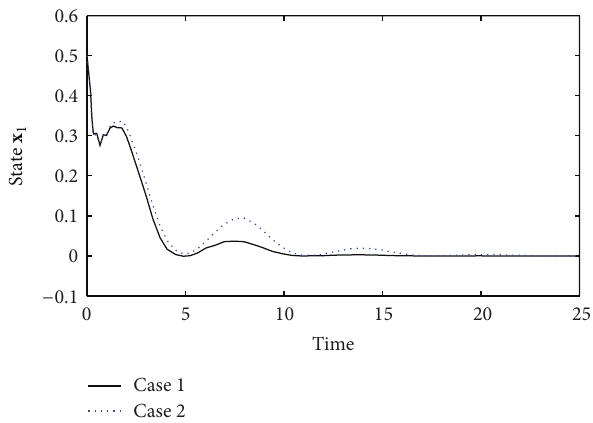
Figure 2: The trajectories of the controlled system state x 1 (𝑡)